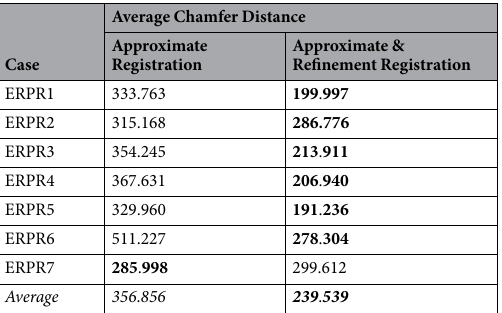
Table 1. A comparison of the registration of breast cases, each containing a set of 5 slides, before and after refinement. Registration quality is measured as the average Chamfer distance between the external boundaries of registered tissue sections. Slides were of the following markers: ER, PR, HER2, H&E, and Negative Control.